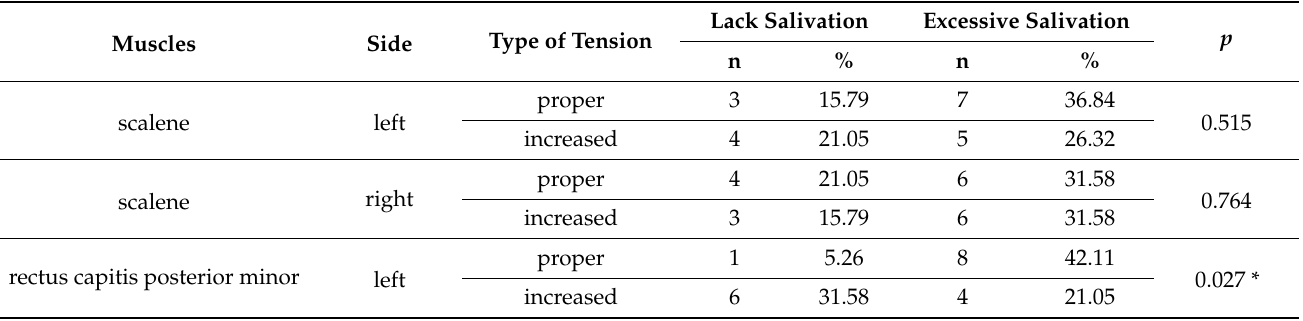
Table 2. The evaluation of dependence between the muscle tension and the occurrence of salivation before therapy (n =